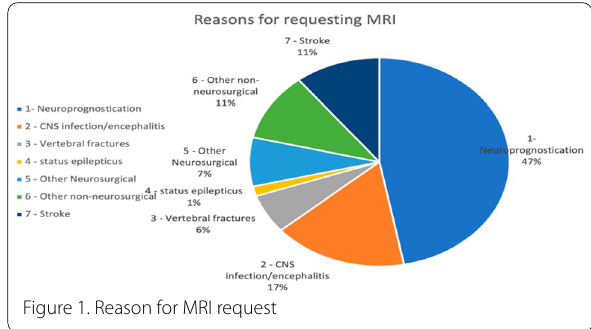
Figure 1. Reason for MRI